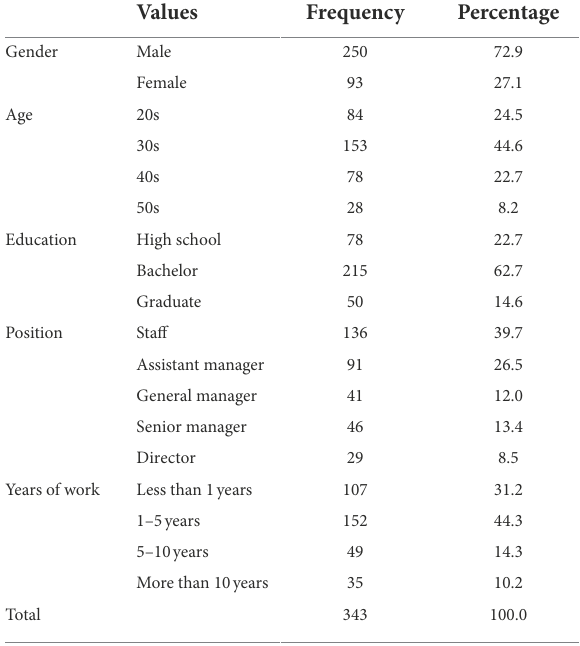
TABLE 1 Sample demographic data ( N =